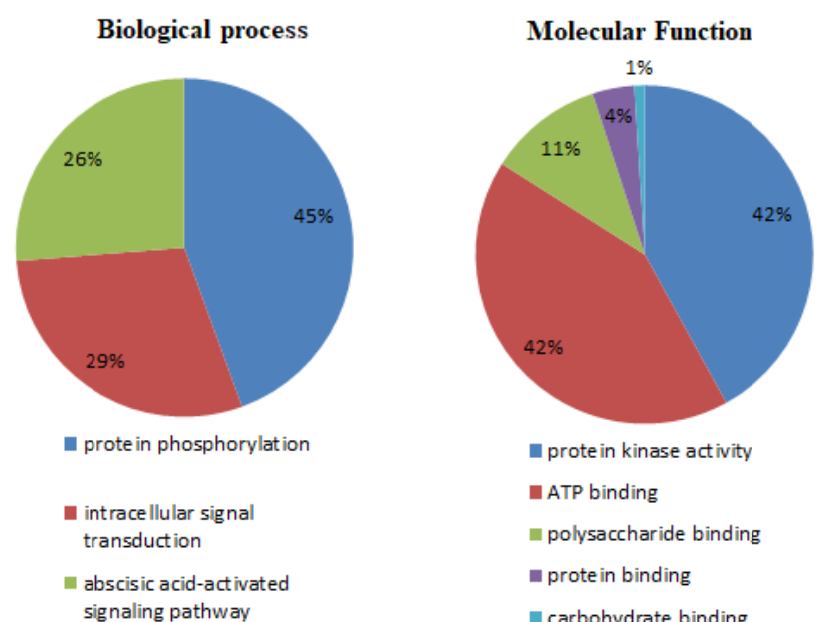
Figure 5. Gene ontology (GO) annotation of 75 G. hirsutum genes, depicting the biological processes and molecular functions of the identified genes. Abbreviations: ATP — adenosine triphosphate.